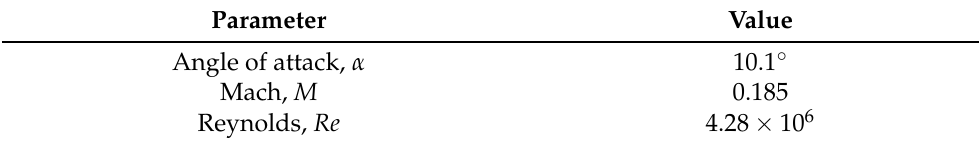
Table 2. Angle of attack and inflow conditions for the NLR 7301 airfoil flow